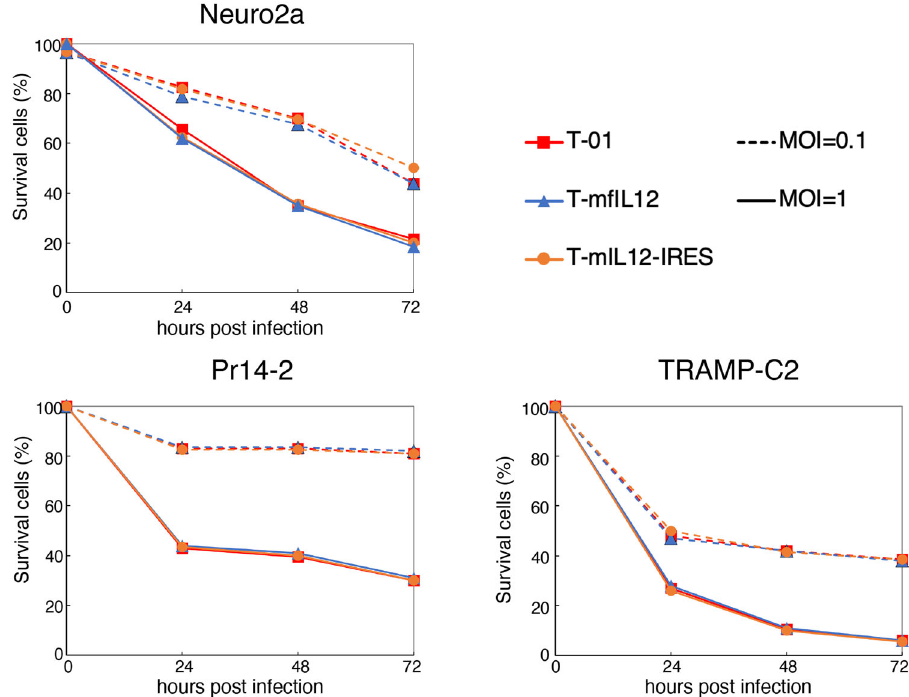
Fig. 3 In vitro cytopathic effects of T-mfIL12 and T-mIL12-IRES. In all three murine cancer cell lines, both T-mfIL12 and T-mIL12-IRES showed cytopathic effects comparable to the control virus T-01 at both multiplicity of infection (MOI) = 0.1 (dotted lines) and MOI = 1 (solid lines). The number of surviving cells was counted daily and expressed as a percentage of mock-infected controls. The results are the means of triplicate